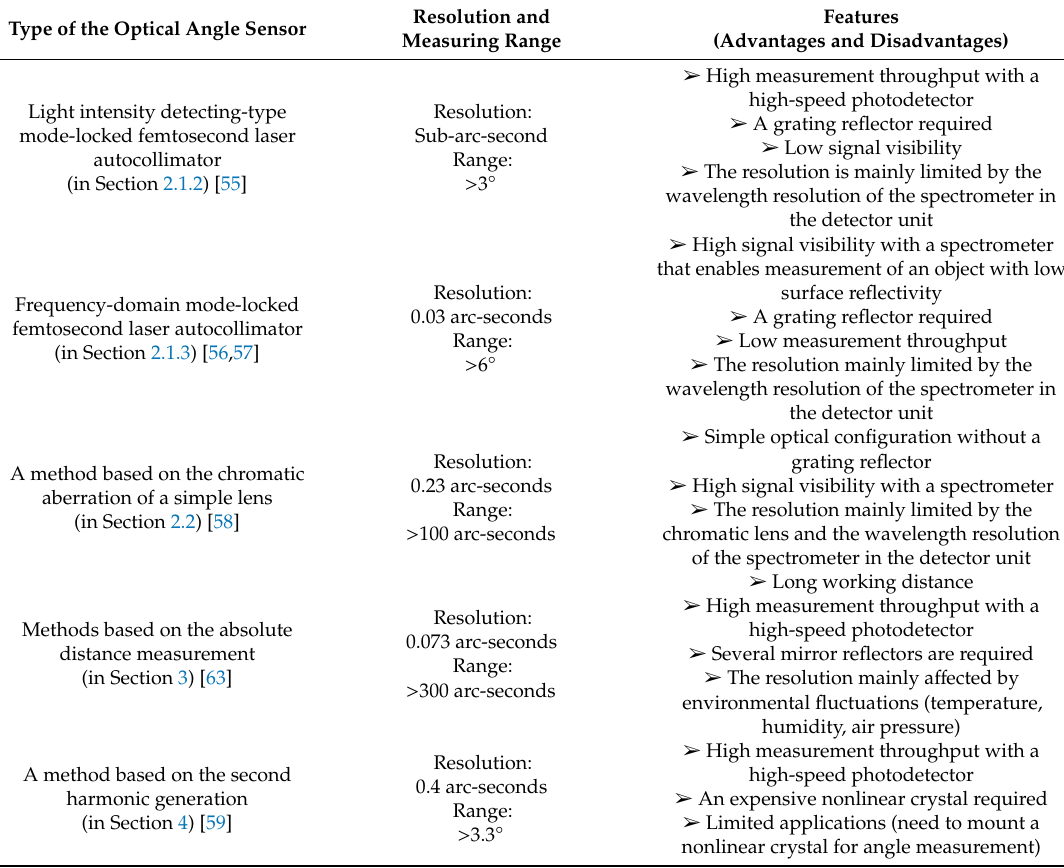
Table 2. Comparison of the techniques reviewed in this